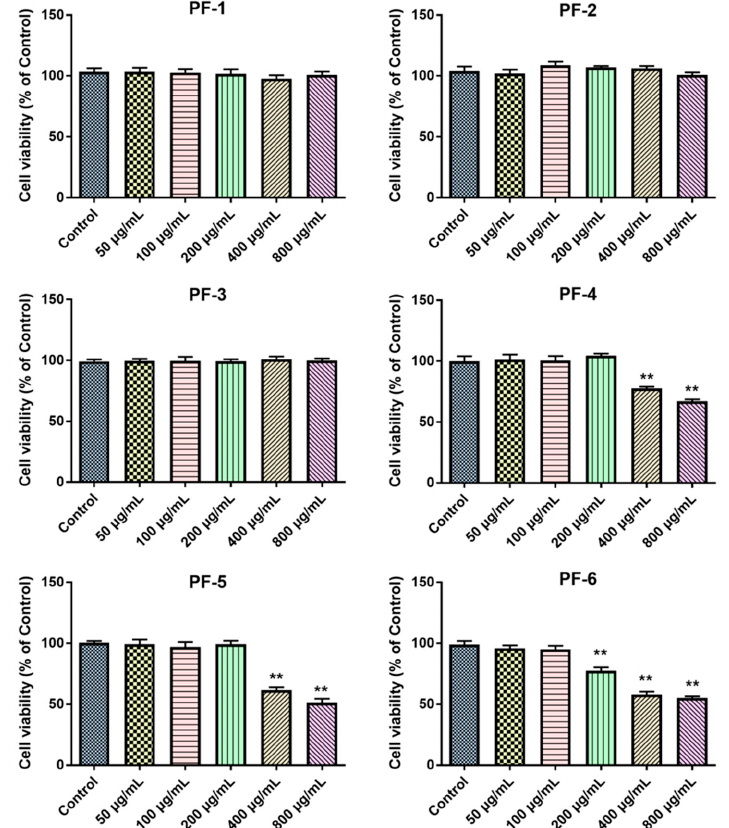
Figure 2. Effects of PF-1 to PF-6 on the cell viability of normal PC12 cells. Cells were treated with different fractions at concentrations of 0 to 800 μ g/mL for 24 h. The cell viability was determined by MTT. ** p < 0.01 vs. the control group.